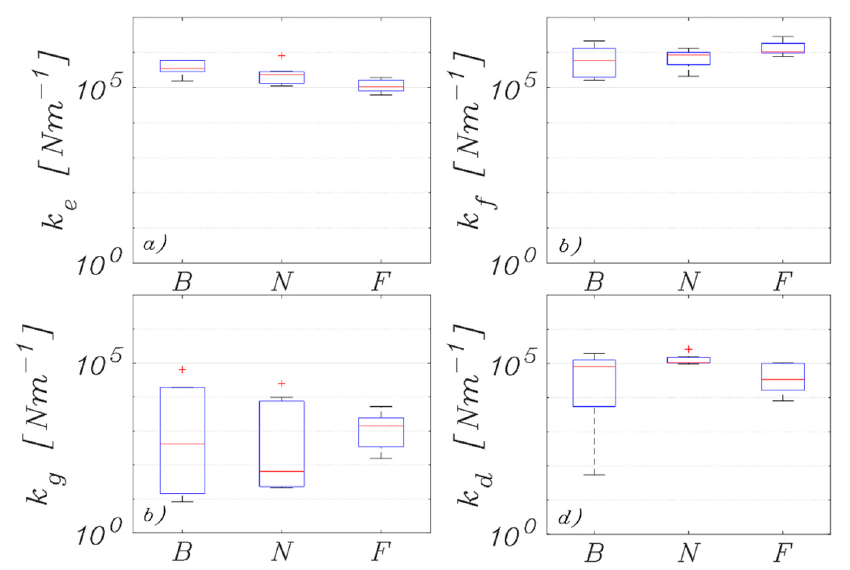
Figure 5. Box plot analysis of: ( a ) the stiffness for the rearfoot sole ( k e ), ( b ) midfoot sole ( k f ), ( c ) forefoot sole ( k g ) and ( d ) the plantar aponeurosis ( k d ) when the COP was in the backward (B), natural (N) and forward (F) positions.